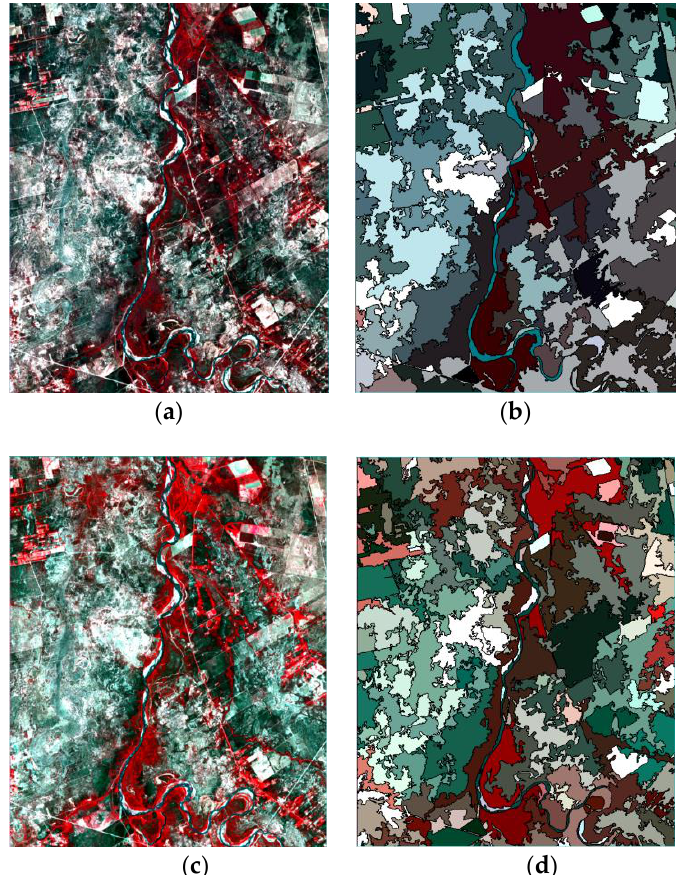
Figure 4. Detail of Landsat 8 imagery: ( a ) winter 2013 and ( c ) summer 2014 pixel imagery. Segmentation into separate objects in ( b ) winter 2013 and ( d ) summer 2014.